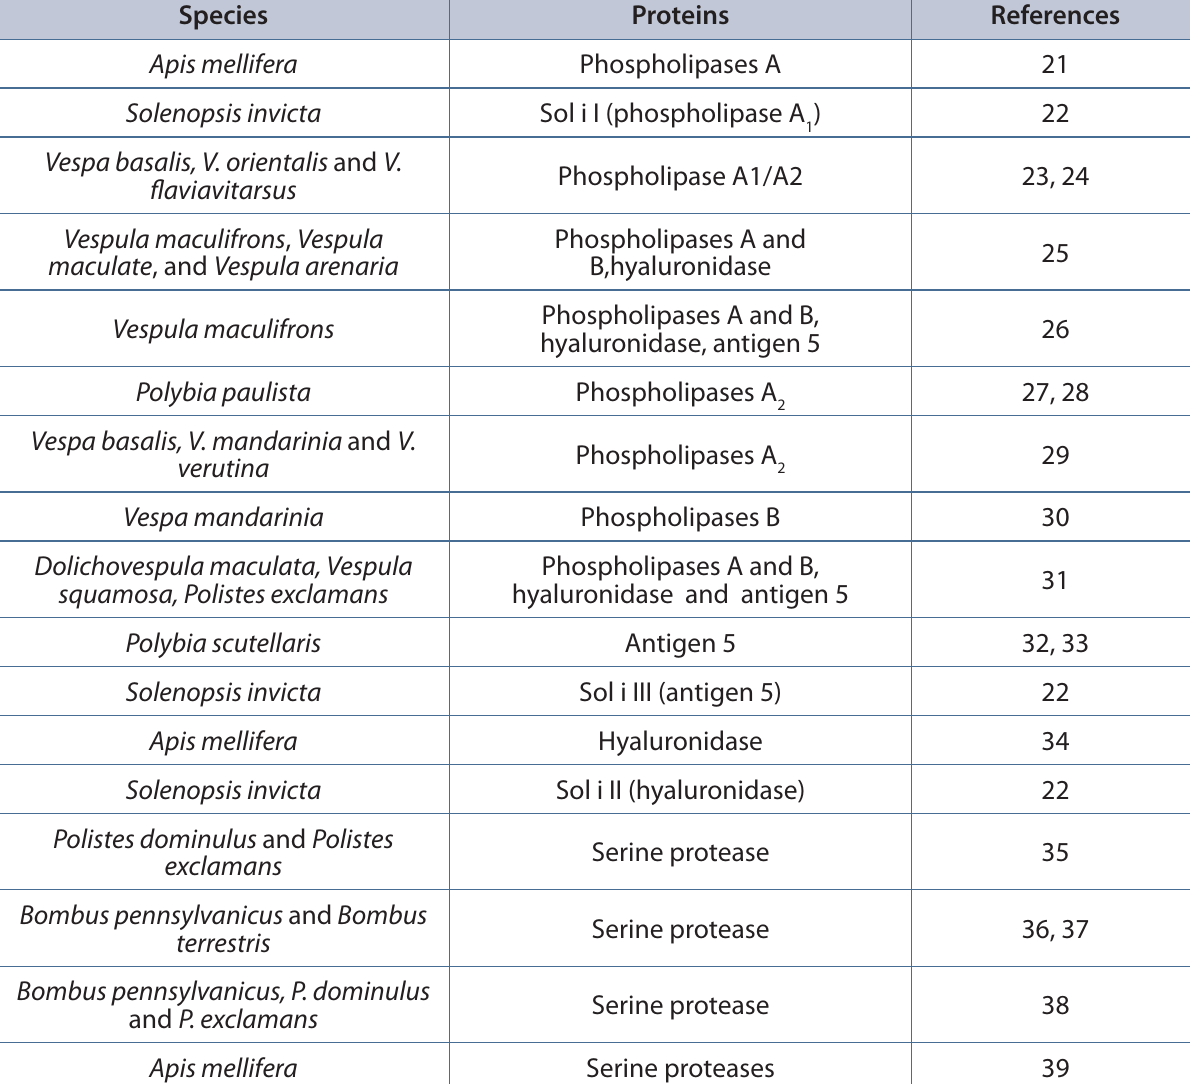
Table 1. Classical proteins isolated from Hymenoptera venoms by basic analytical